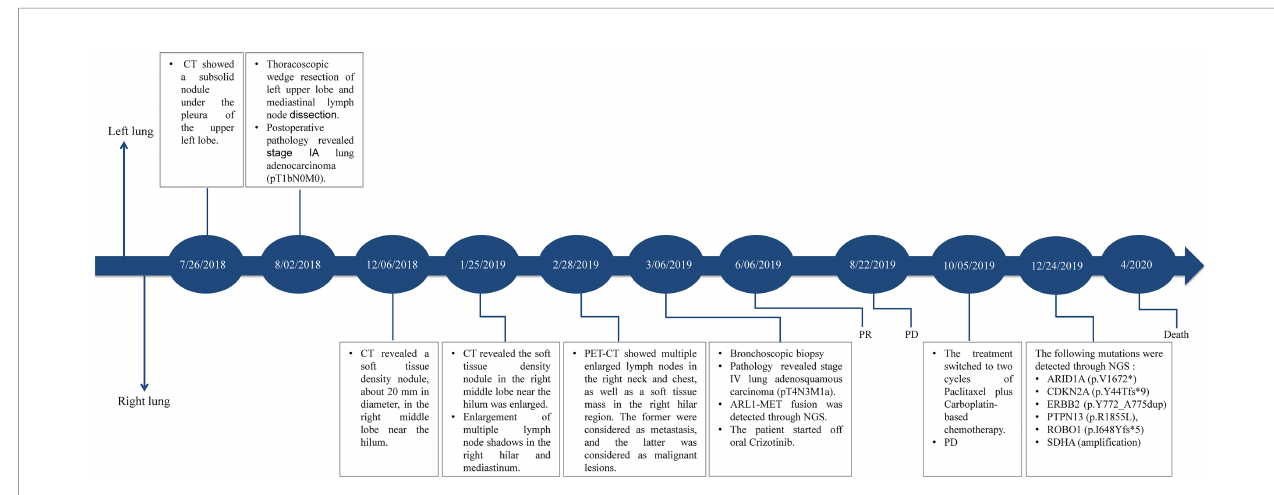
FIGURE 4 | Case timeline. * a premature stop codon due to frameshift mutation or deletion